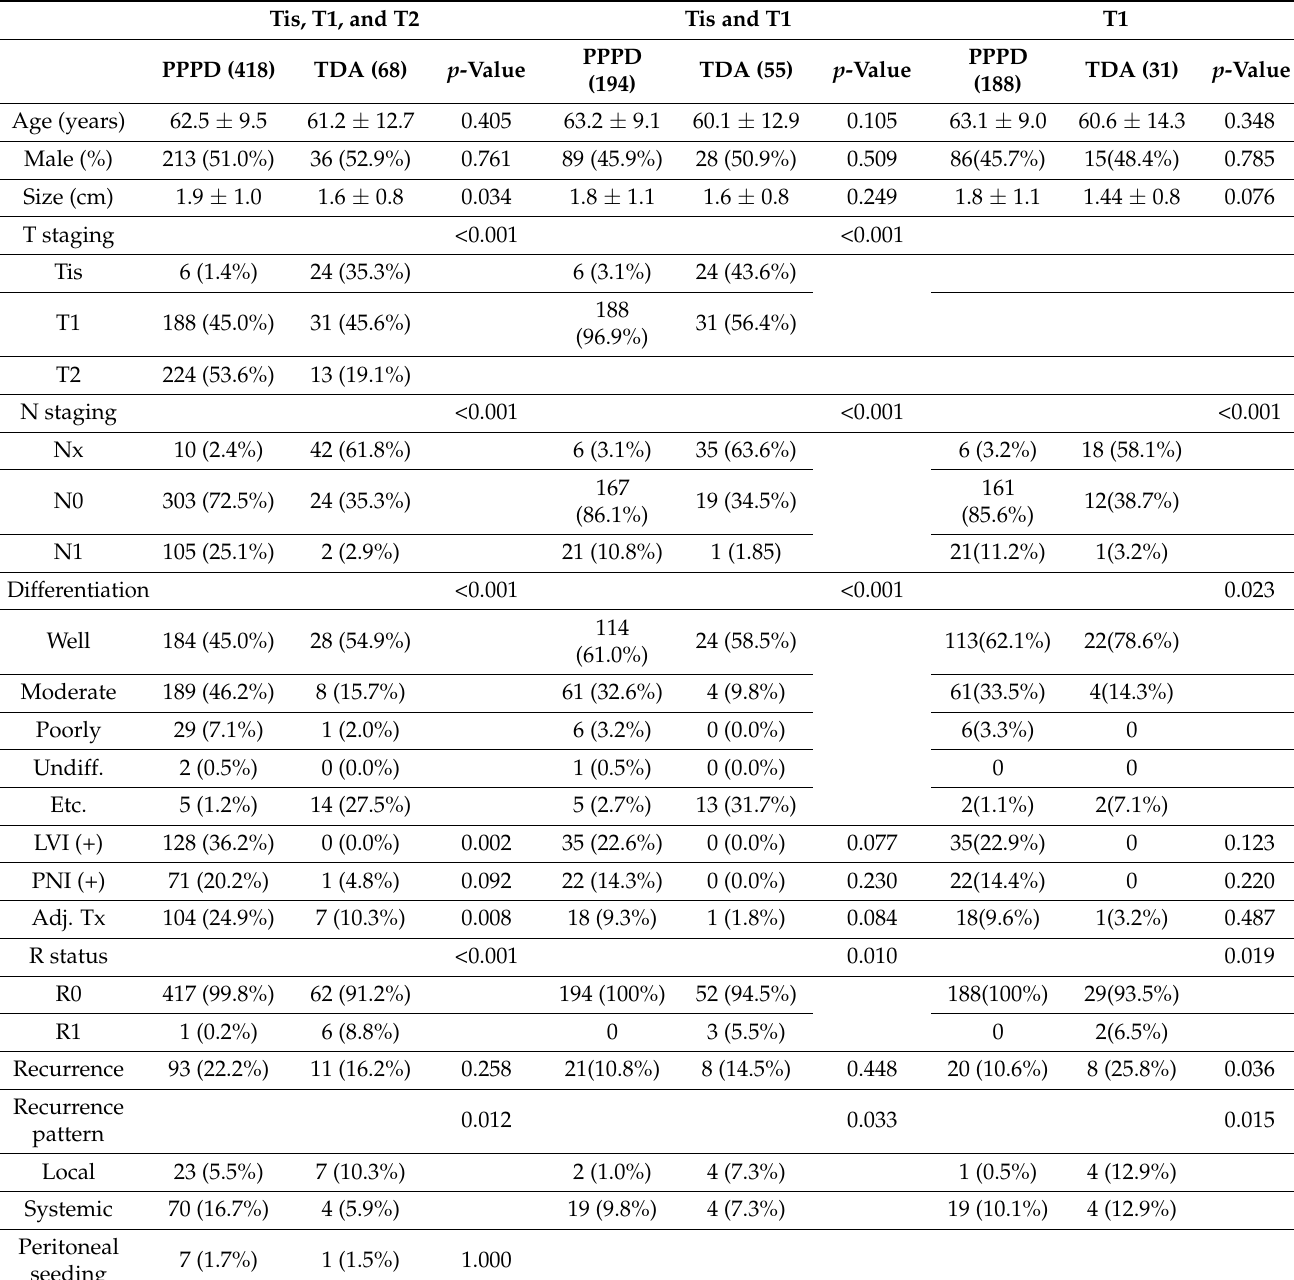
Table 1. Comparison of clinicopathologic characteristics and recurrence between the PPPD and TDA